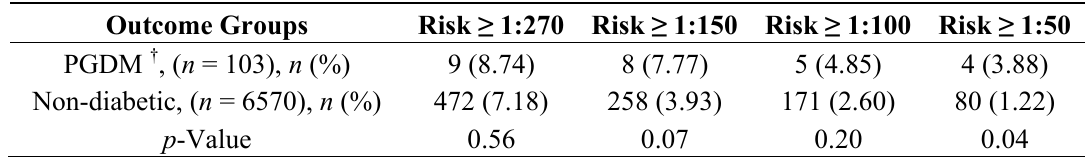
Table 3. Proportion of pregnancies with estimated risk for Down syndrome above cut-offs of 1:270, 1:150, 1:100 and 1:50 among the